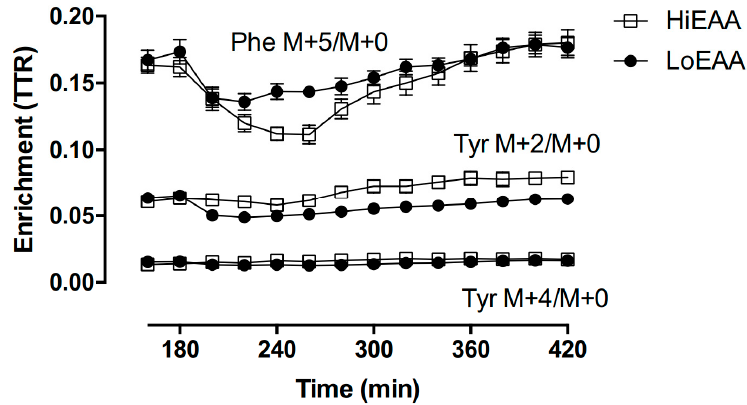
Figure 2. Plasma enrichments of infused tracers (Phe M + 5 / M + 0 and Tyr M + 2 / M + 0) and one (Tyr M + 4 / M + 0) derived from Phe M + 5 through hydroxylation. Samples were taken before and following consumption either the HiEAA or the LoEAA after the 180 min sample was collected. Values ( n = 7) are expressed as mean ± standard error of the mean (SEM). TTR, tracer to tracee ratio; M + 0 is the most abundant form of naturally occurring Phe or Tyr; M + i (e.g., M + 2, M + 4, and M + 5) is heavier than M + 0 by i mass unit.